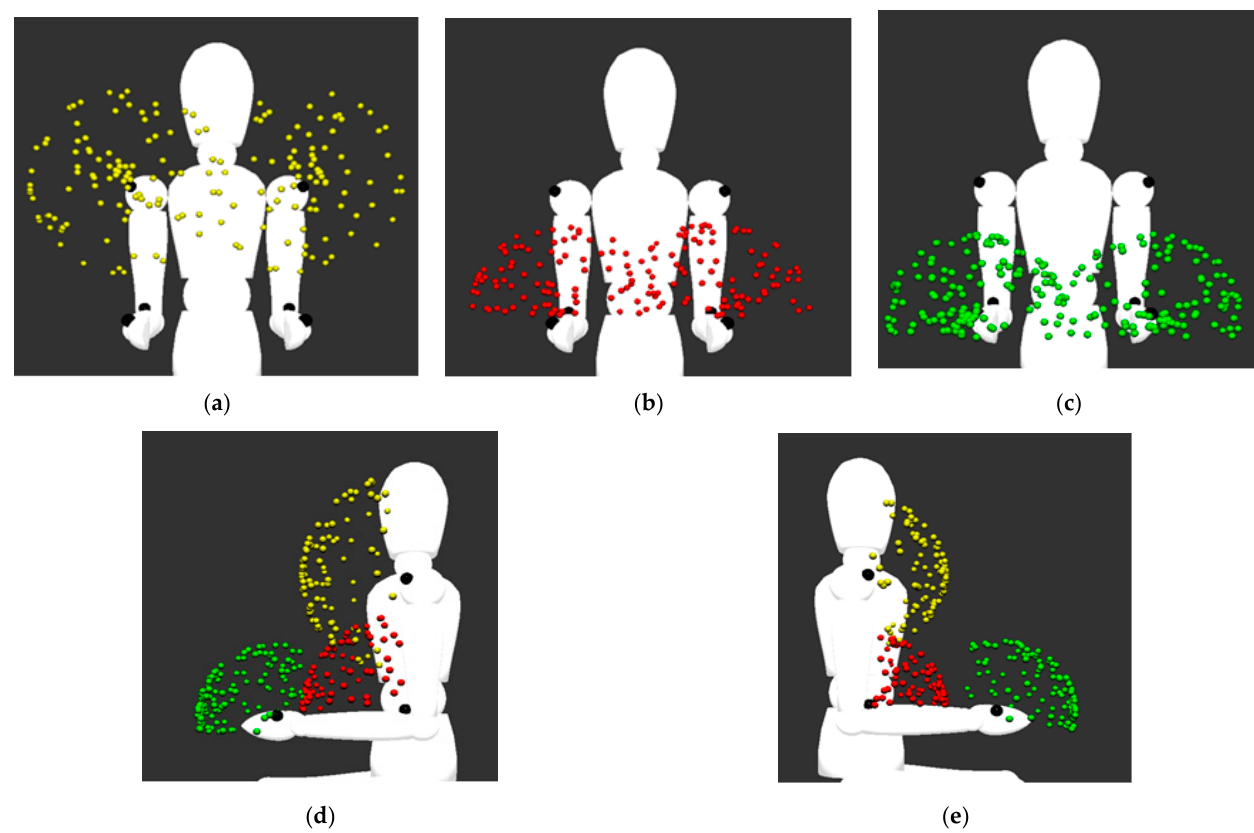
Figure 3. Part of touchers’ hand positions when evaluator clicked a button to stop the hand. ( a – c ) show each body part data from front view and ( d , e ) show all body part data from both side views. Plotted data are relative to positions of 3D model’s shoulder, elbow, and hands for visualization. Thus, actual postures of participants are different.